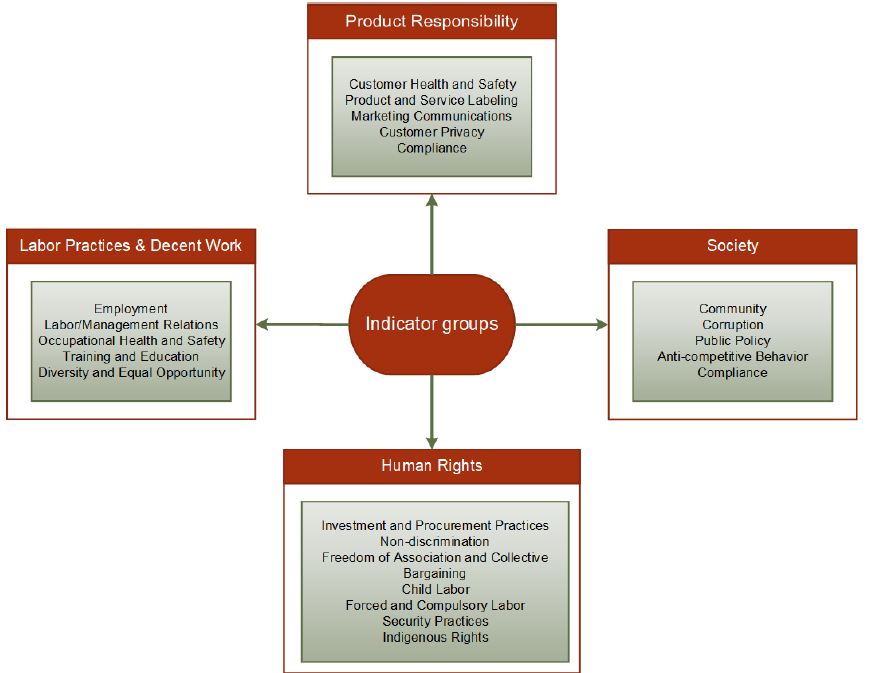
Figure 3. Social KPIs.